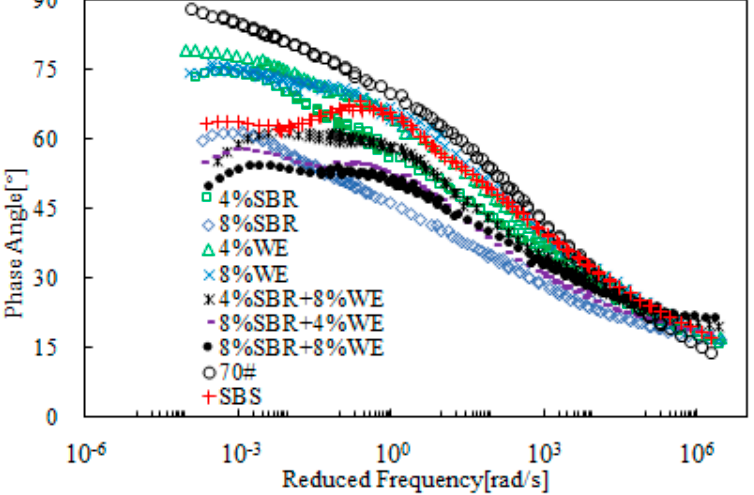
Figure 14. Master curves of the phase angle of SBR + WE-modified bitumen emulsion.